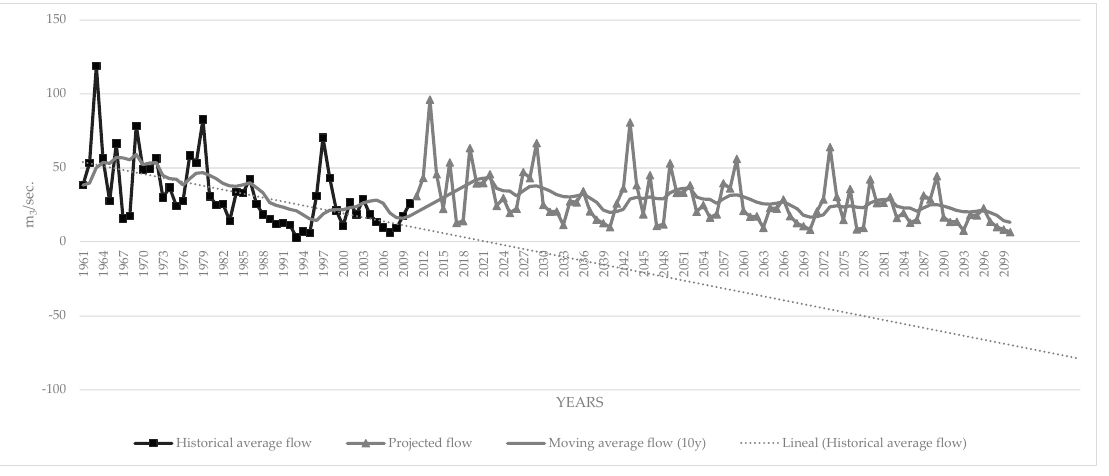
Figure 11. Historical and projected flow (m 3 /s), Cala center. Source: Own elaboration and ENDESA.